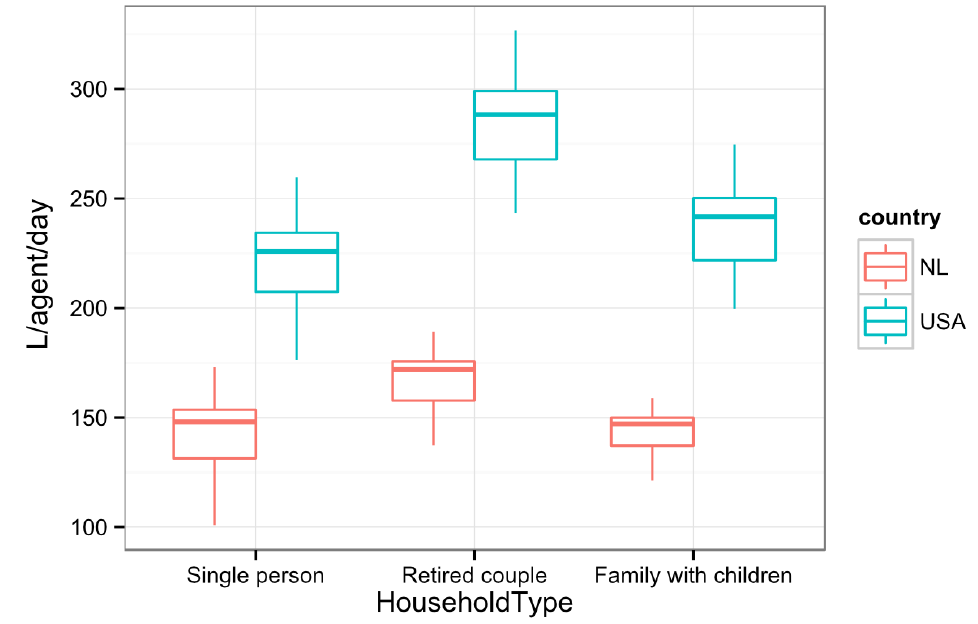
Figure 5. Distribution of water usage per agent per day by household type and country. The middle box is the 50% percentile, the bottom and top of the box are the 25% and 75% per-centiles of observations. Each boxplots represents 1200 model runs and 12 households worth of data, except for U.S. single which represents 12 households worth of data but has three times more 3600 model